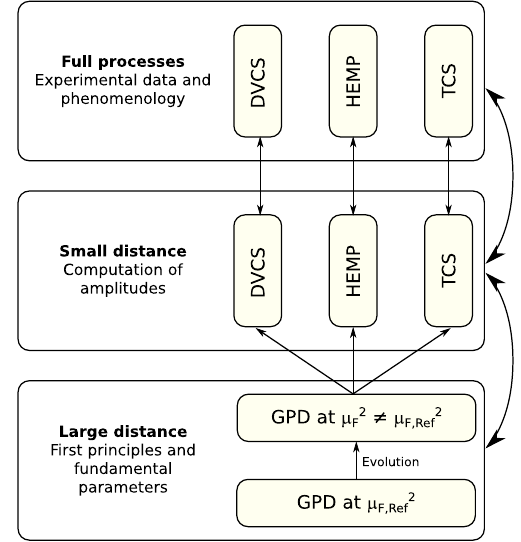
Fig. 3 The computation of an observable in terms of GPDs is gener- ically layered in three basic steps: description of the hadron structure with nonperturbative quantities, computation of coefficient functions, and evaluation of cross sections